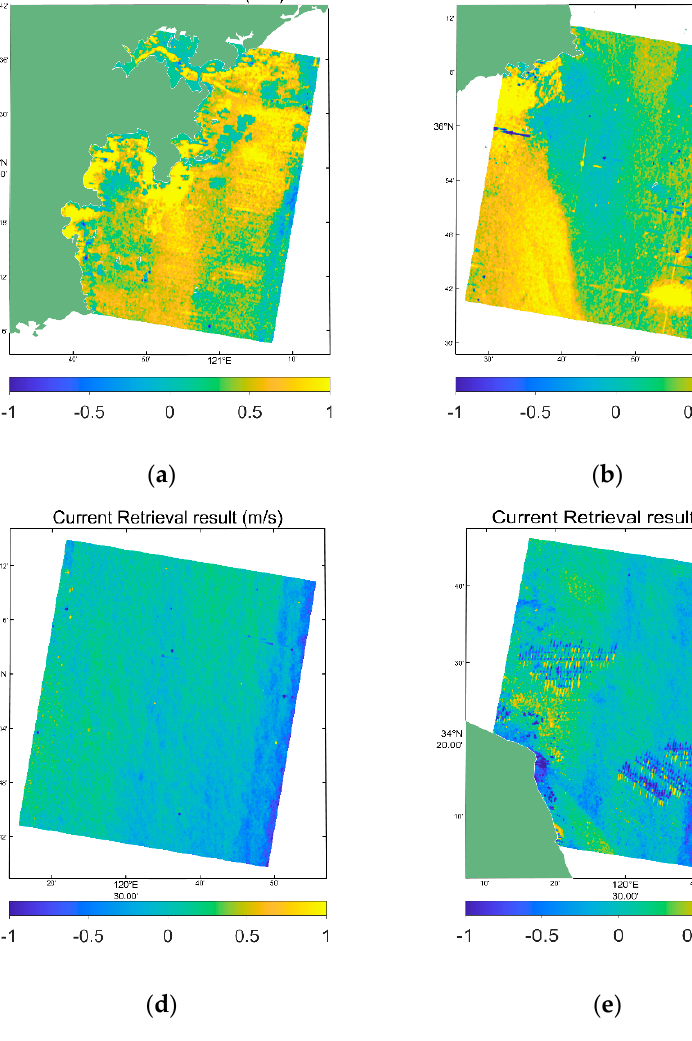
Figure 11. Results of retrieving the ocean surface currents. ( a – e ) are retrieving the ocean surface currents from the five scenes in the Figure 1.